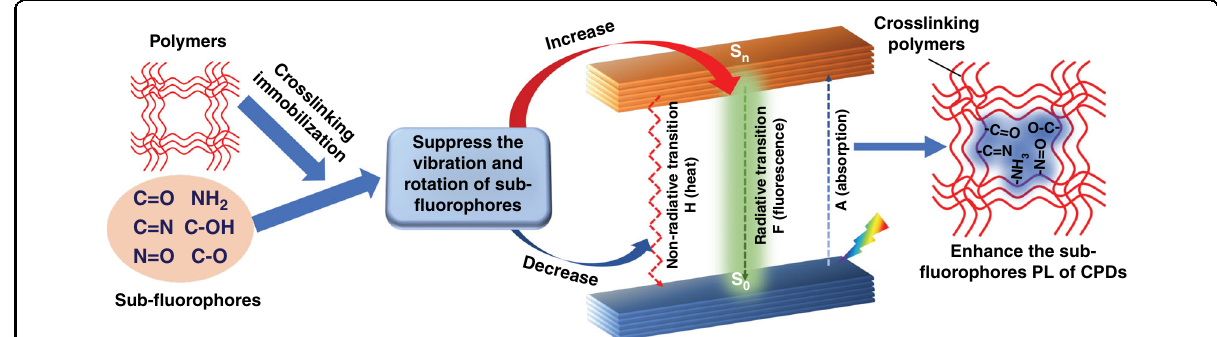
Fig. 1 Schematic of cross-link-enhanced emission effect. Cross-linking restricts the vibration and rotation of sub- fl uorophores (heteroatom- containing double bonds (C = O, C = N, N = O) and single bonds (amino based groups, C – O)), leading to the increase of radiative transition and decrease of the non-radiative transition, thereby enhancing the sub- fl uorophores PL of CPDs (S 0 : Ground singlet state, S n : Excited singlet state)